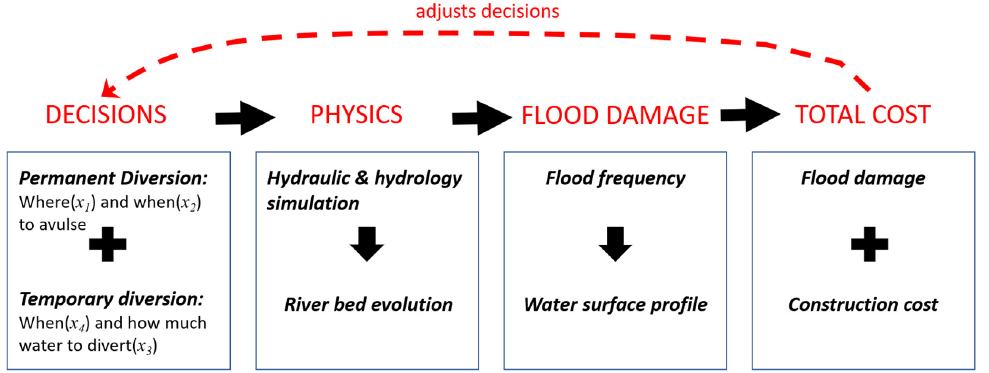
Figure 1. The decision tool for the flood control problem. One part is a physical model that simulates the daily evolution of the riverbed of the lower Yellow River and the resulting water profile. Daily streamflows and